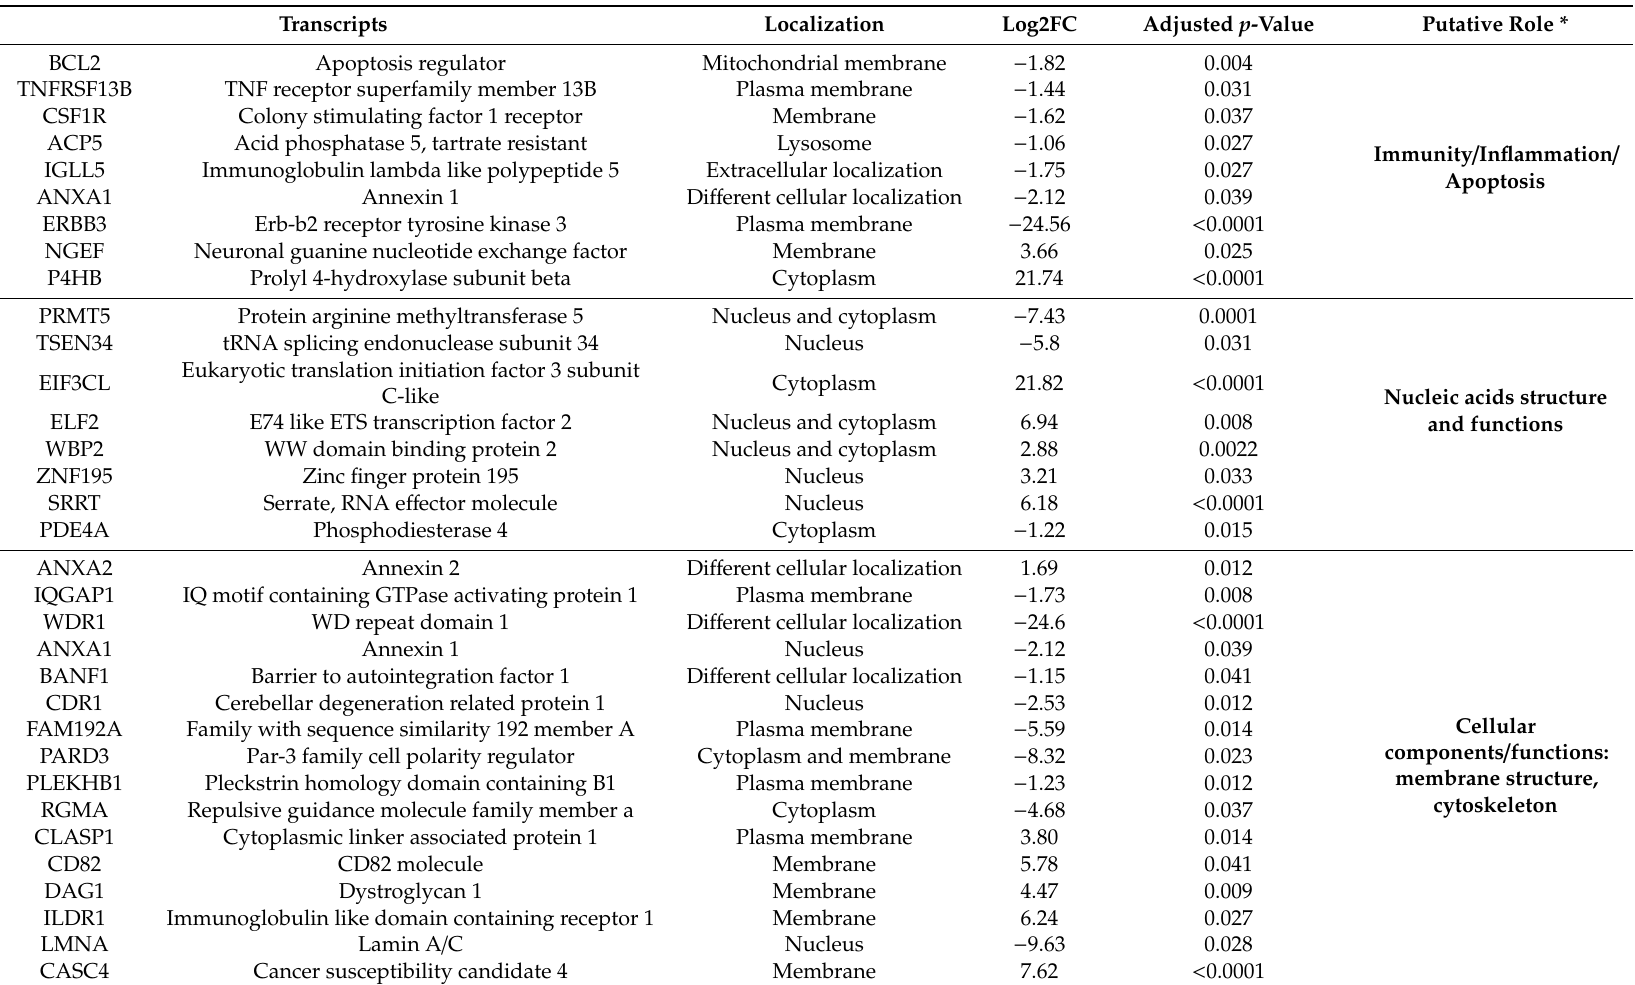
Table 1. Significantly up-expressed and down-expressed human genes in Obese (OB) vs Lean (CO) and their putative role (based on KEGG and GOTERM